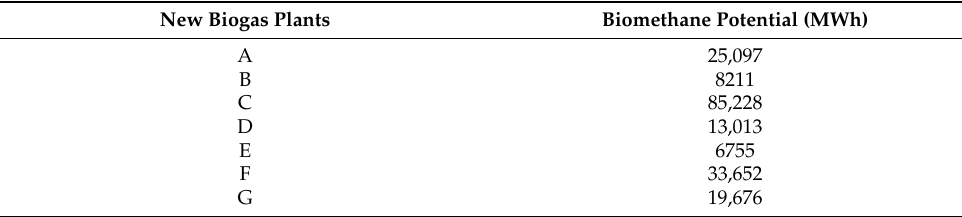
Table 6. Biomethane production potential in newly planned biogas plants in this